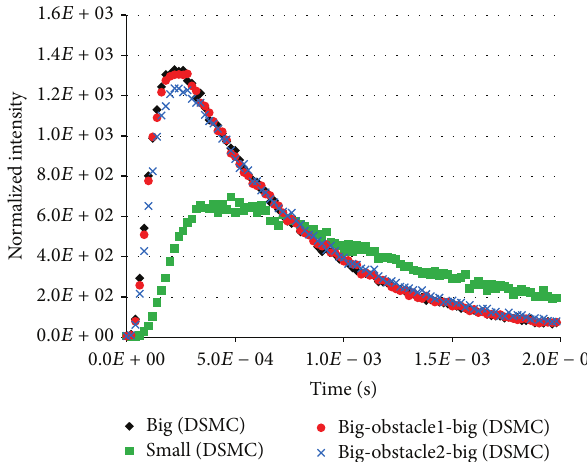
Figure 10: Pulse response curves of geometries shown in Figure 9.